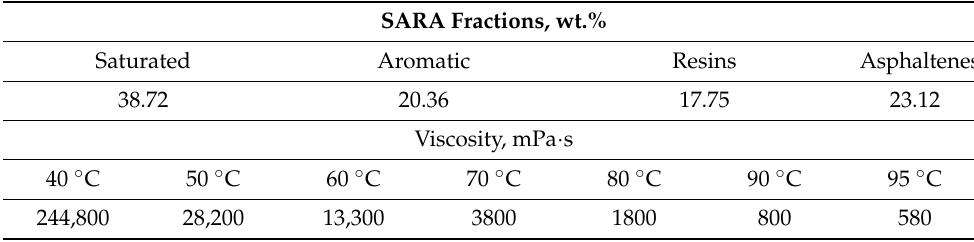
Table 9. The composition and properties of the extra heavy